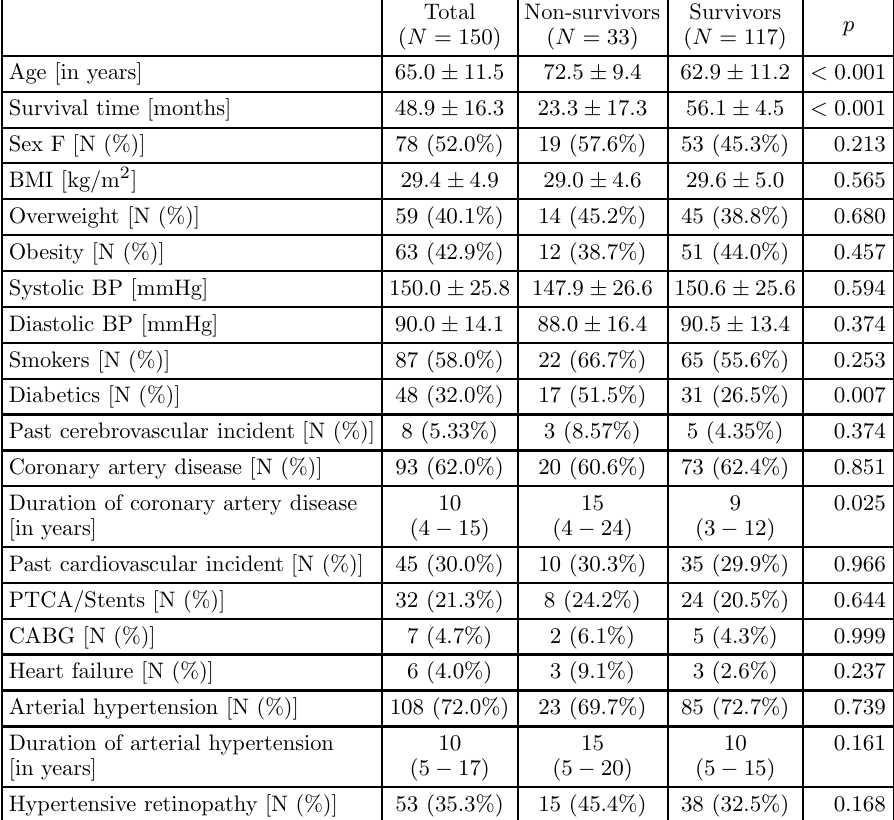
Table 1. Basic characteristics of survivors and non-survivors